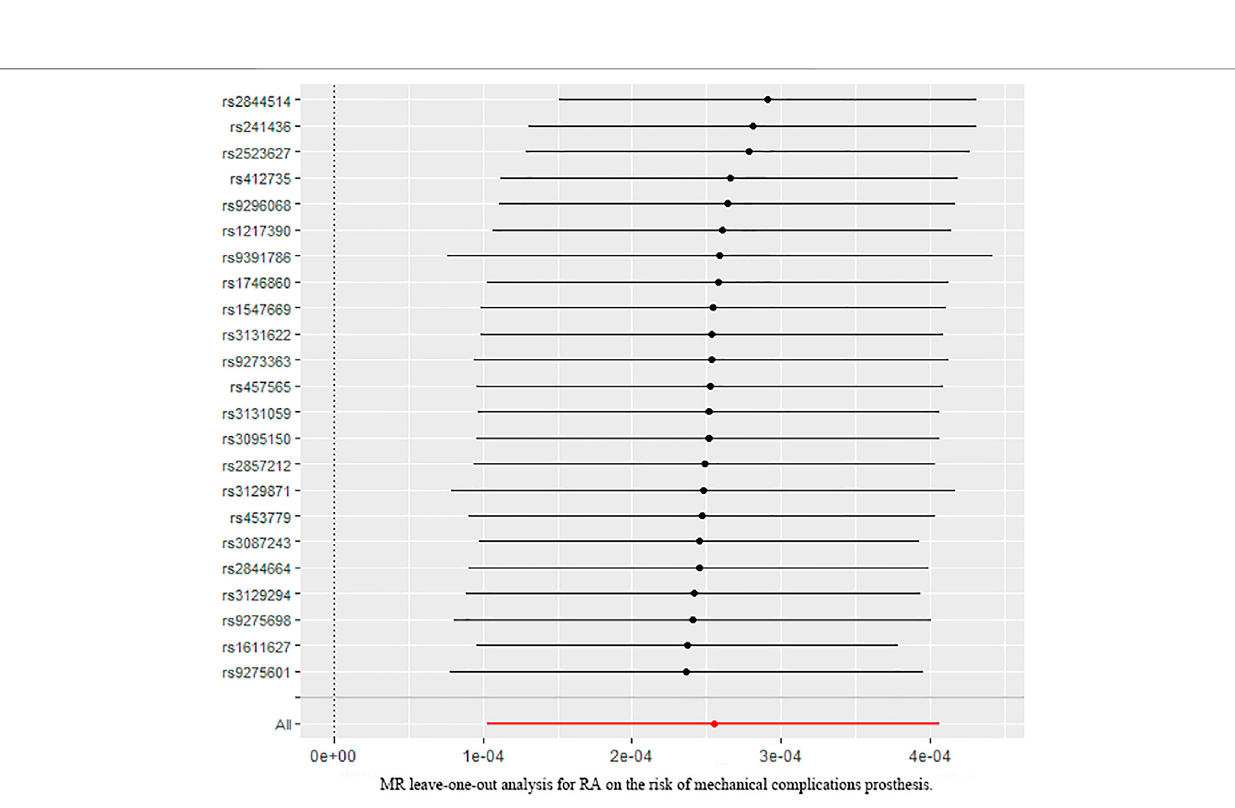
Frontiers in Genetics |